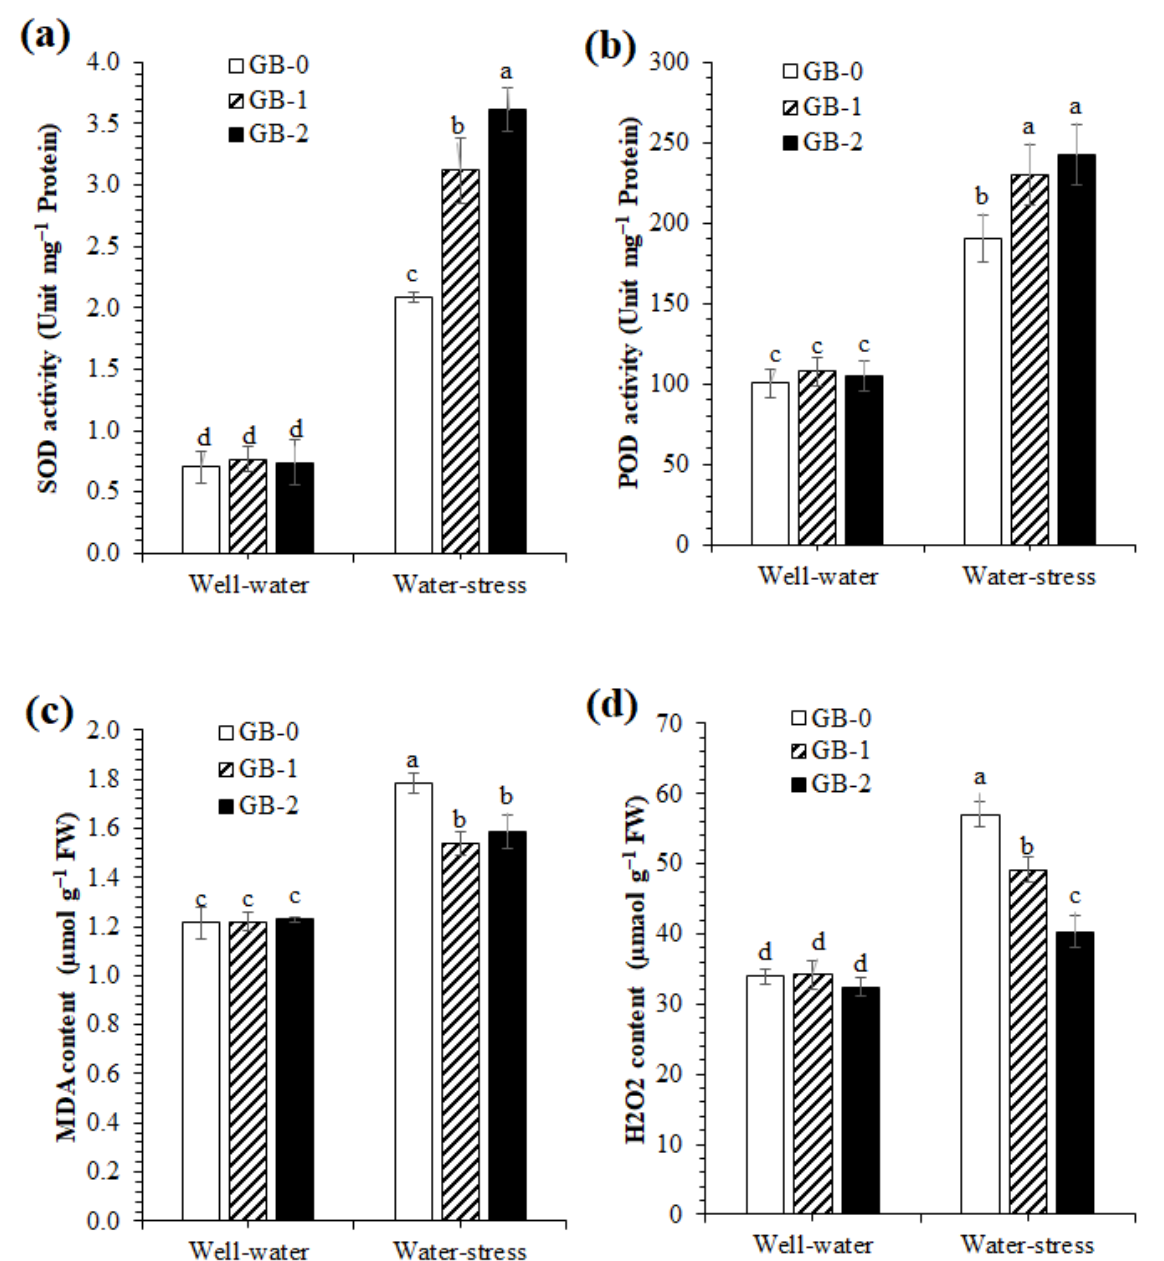
Figure 3. Effect of GB root-priming on antioxidant (SOD, POD) activities ( a , b ) and MDA, H 2 O 2 , content ( c , d ) in the roots of wheat seedling grown under well-water and water-stress conditions. Each value represents the mean ± standard deviation (SD) of three replicates. Bars showing different letters represent the significant differences at p ≤ 0.05 as determined by LSD test.